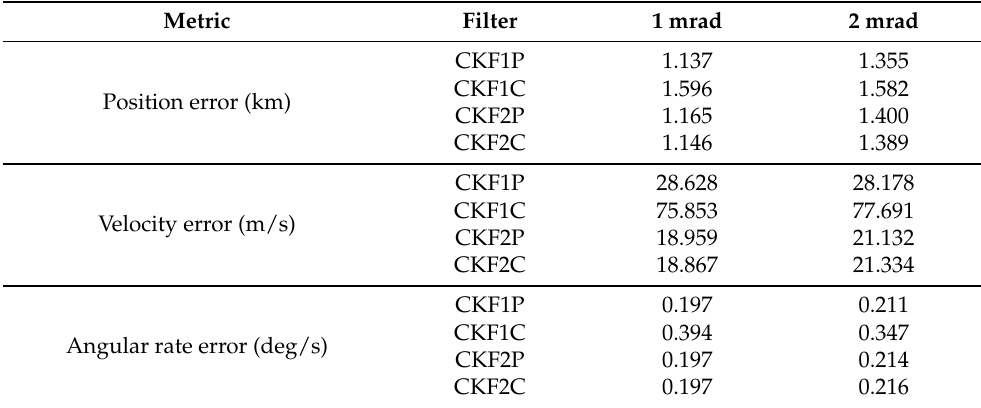
Table 4. RTAMS position, velocity, and angular rate errors for CKF1P, CKF1C, CKF2P, and CKF2C using the prior variance P 0,p,1 .